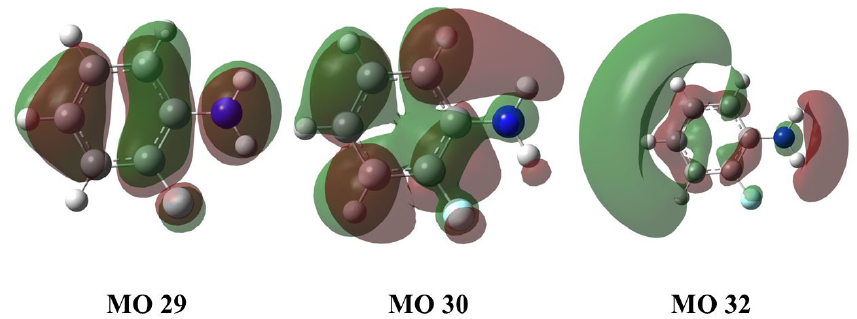
4 of 16 Table 1. Wavelength, vertical excitation energy (E), oscillator strength (f) and transition orbital of S 1 , S 2 and T 1 states of o ‐ fluoroaniline molecules. Calculation method and basis set: TD ‐ DFT and